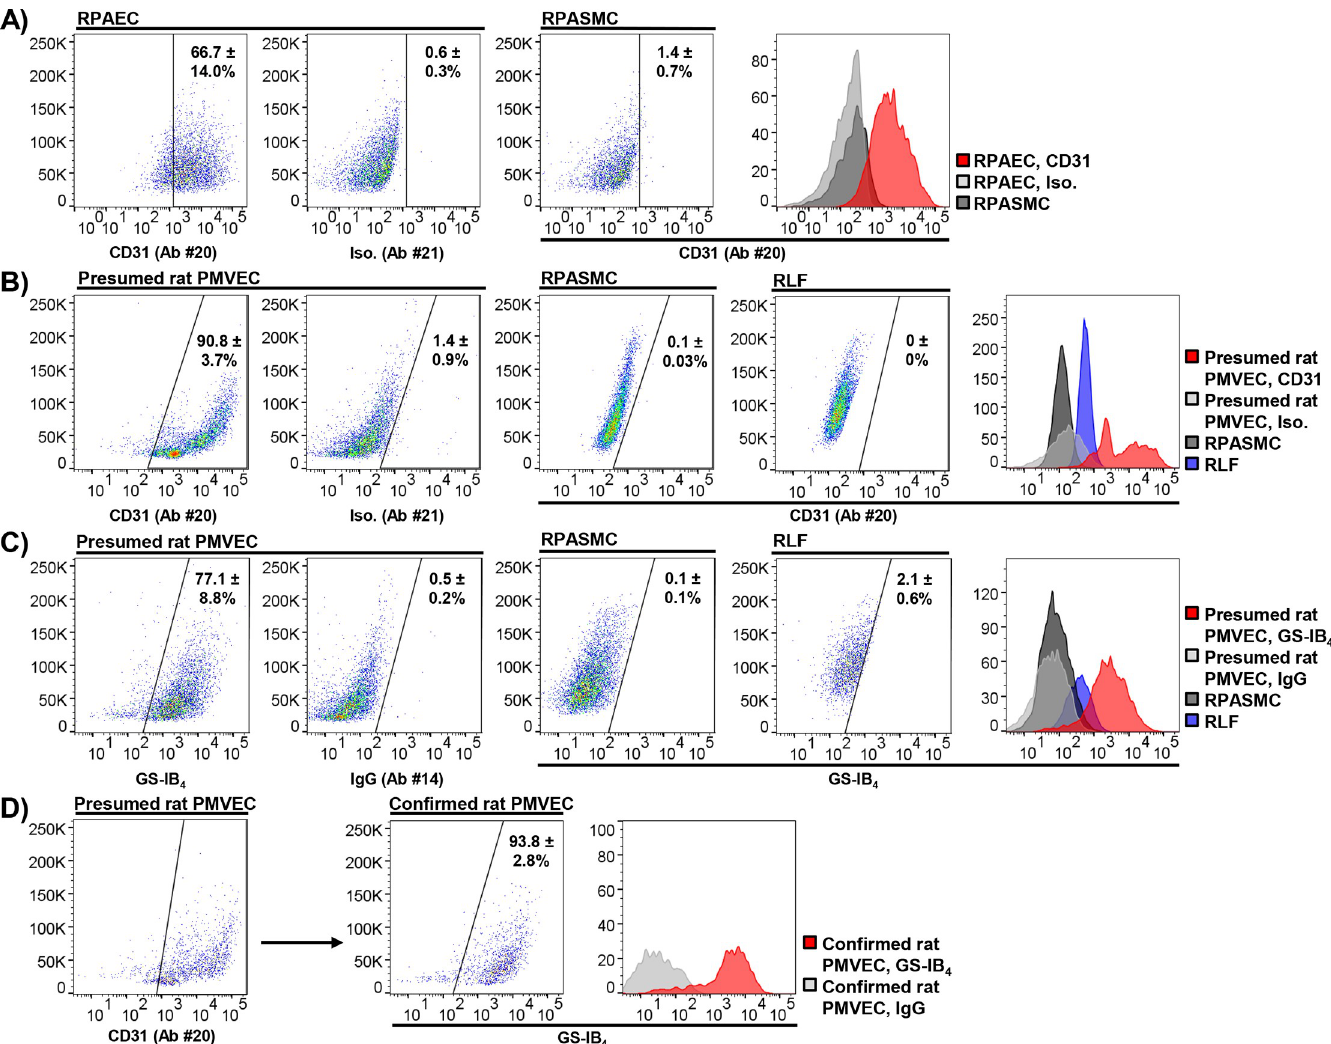
Fig 5. Fluorescence-activated cell sorting (FACS) permits isolation of rat pulmonary microvascular endothelial cells (PMVECs). Presumed rat PMVECs isolated from peripheral lung by immunomagnetic anti-CD31 bead selection, as well as commercial rat pulmonary artery endothelial cells (RPAECs), rat lung fibroblasts (RLFs) and RPASMCs were analyzed by flow cytometry directed against endothelial surface markers. (A) Anti-CD31 Ab #20 selectively labeled RPAECs relative to isotype control and RPASMCs (N = 4/condition). (B) Presumed rat PMVECs demonstrate specific anti-CD31 labeling relative to commercial rat lung fibroblasts (RLFs) and RPASMCs (N = 3/condition). (C) Presumed rat PMVECs also demonstrate specific signal for isolectin 1-B 4 from Griffonia simplicifolia (GS-IB 4 ) relative to RLFs and RPASMCs (N = 4/condition). (D) Over 90% of CD31-positive presumed rat PMVECs co-label with GS-IB 4 (N = 3/condition). Confirmed rat PMVECs were defined as those cells positive for both CD31 and GS-IB 4 by flow cytometry. Representative plots and histograms shown. Means, % CD31 or GS-IB 4 positive. Ab, antibody; Iso, Isotype control.